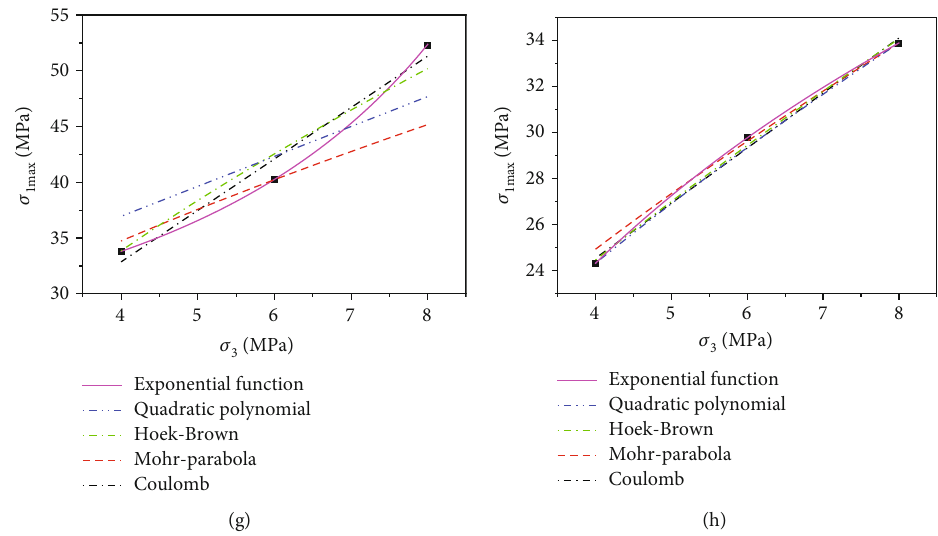
Figure 2: Triaxial compressive strength of coal samples and fi tted curves of fi ve yield criteria. (a) DT Natural coal. (b) BD Natural coal. (c) XH Natural coal. (d) YC Natural coal. (e) DT Water-saturated coal. (f) DT Seepage coal. (g) BD Seepage coal. (h) XH Seepage